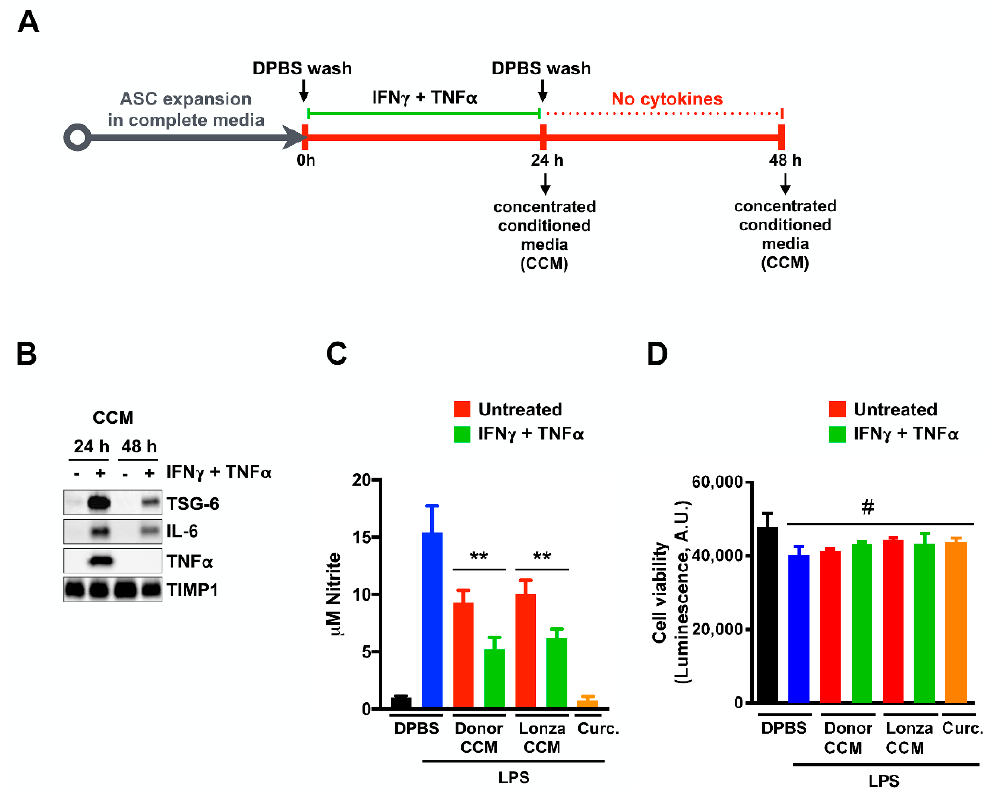
Figure 1. Cytokine priming of adipose stem cells (ASCs) enhances the anti-inflammatory composition of conditioned medium. ( A ) Schema for preparation of exogenous cytokine-stimulated ASC concentrated conditioned medium (ASC-CCM). ASCs are expanded in culture media, washed with Dulbecco’s phosphate-buffered saline (DPBS), and then cultured in media with 10 ng/mL IFN γ , 20 ng/mL Tumor necrosis alpha (TNF α ) for 24 h. Cells were then washed with DPBS and cultured for an additional 24 h without IFN γ or TNF α . Conditioned media collected at that time was concentrated (CCM) using centrifugal concentrators with a 3 kDa molecular weight cutoff. ( B ) Immunoblot analysis of TNF-stimulated gene 6 protein (TSG-6), Immunomodulatory Interleukin-6 (IL-6), TNF α , and tissue inhibitor of matrix metalloproteinase 1 (TIMP1) in CCM from untreated or cytokine treated ASCs at t = 24 h or 48 h of the aforementioned preparation scheme. ASC-CCM was normalized to 50 μ g/mL in each sample. ( C ) Biochemical assessment of NO release from BV2 cells using the Griess assay. BV2 cells were treated with 5 μ g/mL of 48 h CCM from untreated (red bars) or cytokine treated (green bars) donor derived (Donor CCM) or Lonza ASCs (Lonza CCM) for 1 h then with 50 ng/mL Lipopolyaccharide (LPS) for an additional 24 h. To determine baseline and maximum nitrite, BV2 cells were treated with DPBS alone (black bar) or with DPBS and then LPS (blue bar). Curcumin (Curc.; 10 μ M) was used as a positive control for suppression of LPS-mediated activation (orange bar). Data represent Mean ± SD from at least three technical replicates. **, p < 0.01 ( D ) Luminescence-based assessment of BV2 viability using Cell-TiterGlo. #, p > 0.05. Data represent Mean ± SD from at least three replicates.